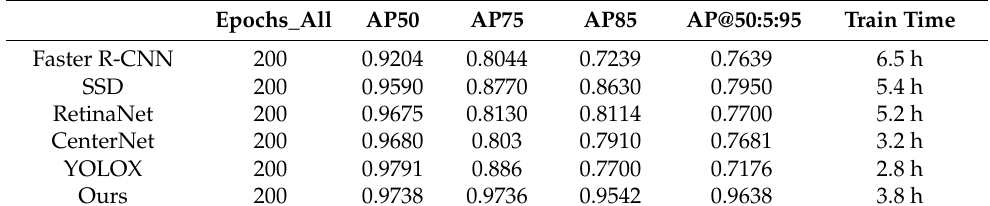
Table 6. Comparison results with other methods.